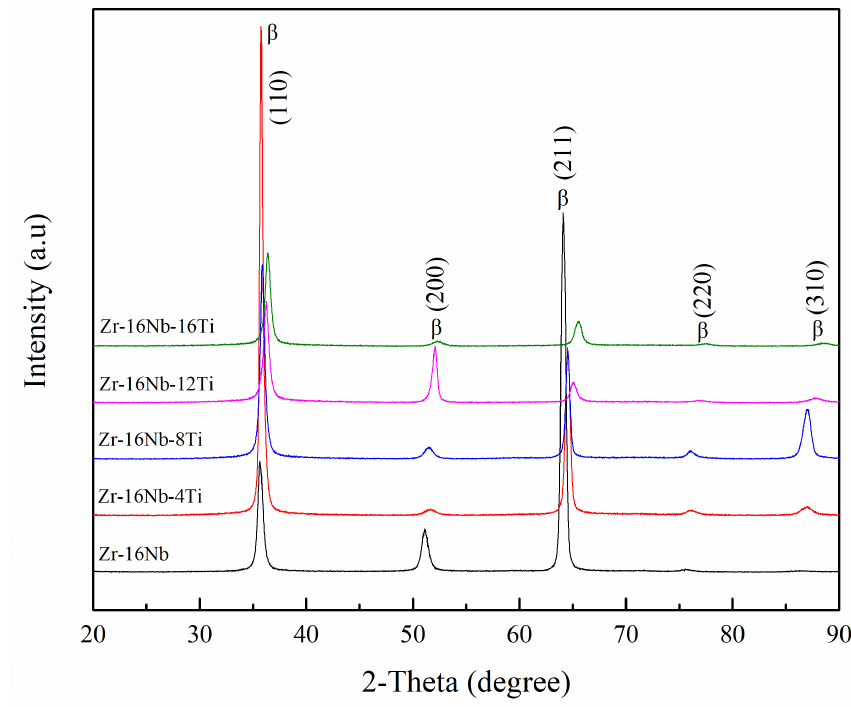
Figure 1. XRD patterns of the Zr-16Nb-xTi alloys.